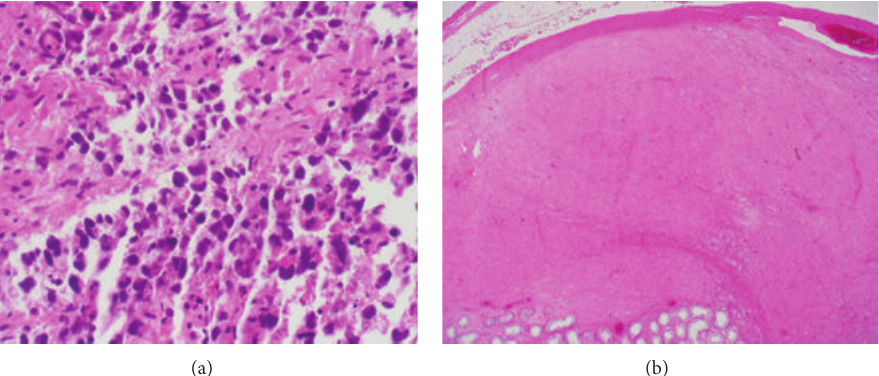
Figure 3: (a) Renal biopsy showing classic seminoma histology. H&E, original magnification 200x. (b) Testis showing fibrosis consistent with regressed seminoma. H&E, original magnification 20x.